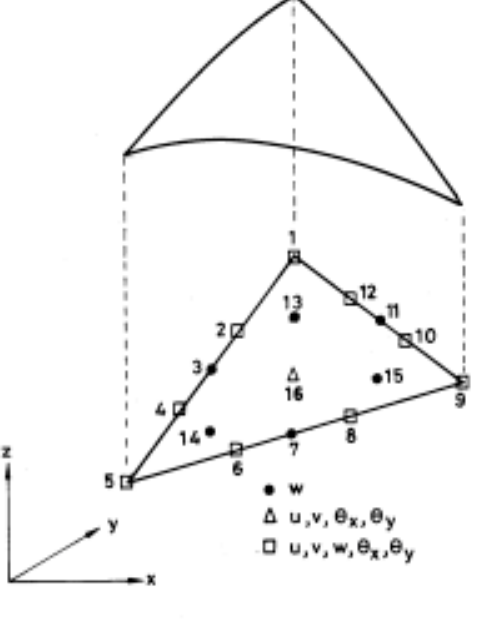
Fig. 1. A typical shell element projected in the base